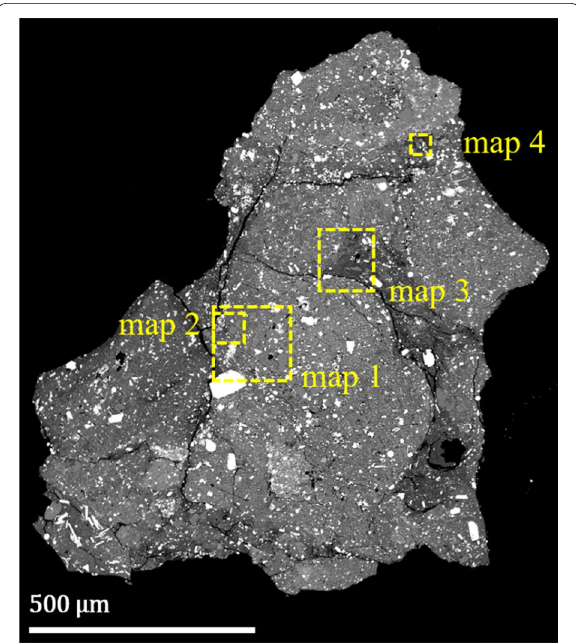
Fig. 3 BSE image of C0033‑04 after epoxy fixation. SR‑XRF overview scans are highlighted in yellow